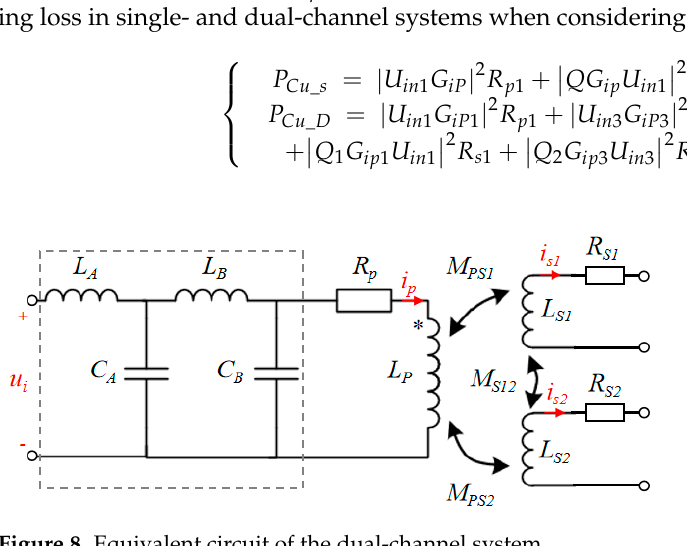
Figure 8. Equivalent circuit of the dual-channel system.